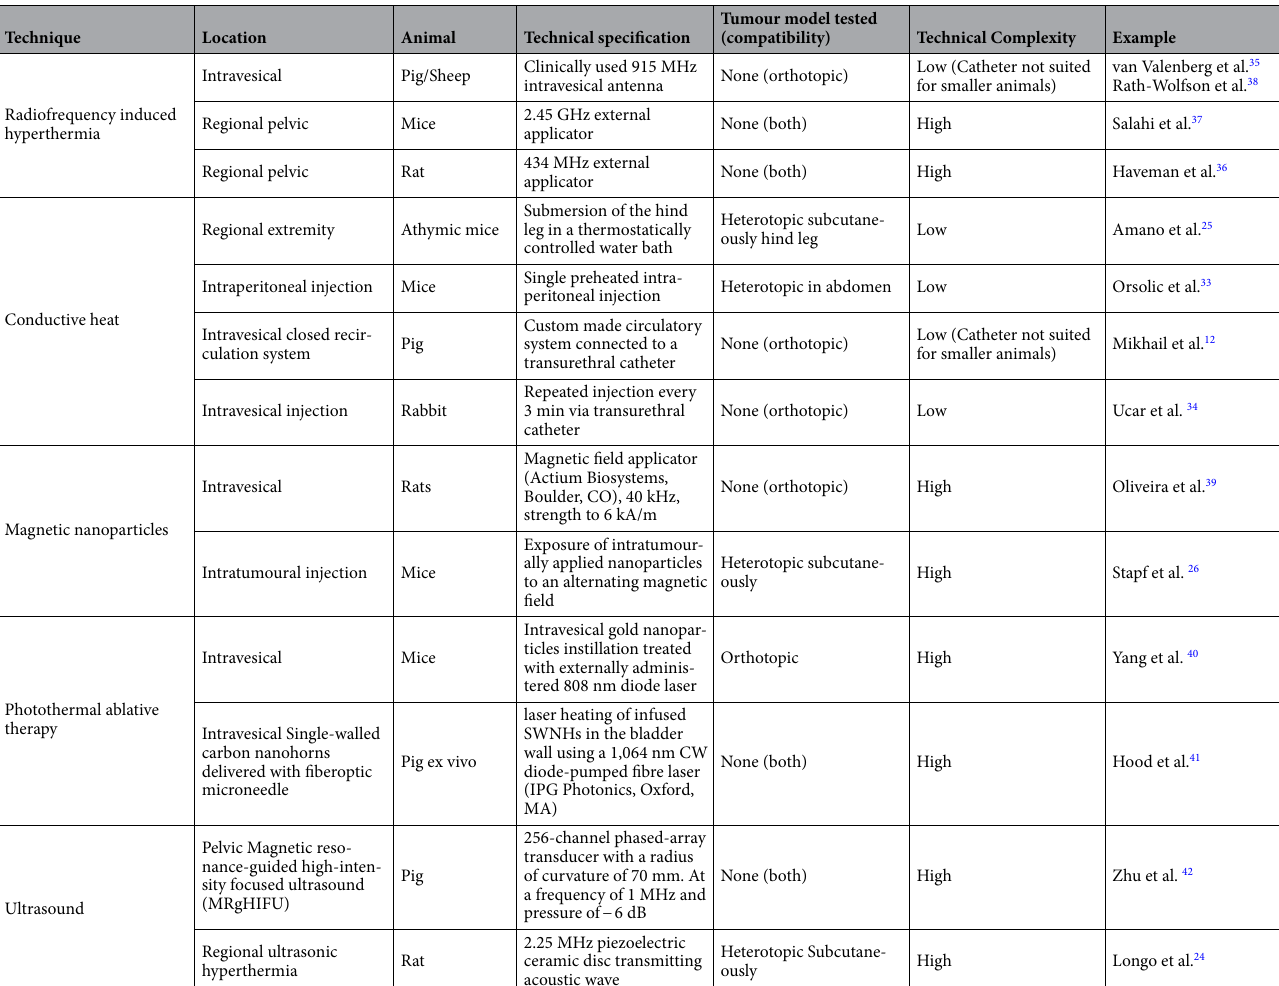
Table 1. Overview of several methods to simulate HIVEC in animal